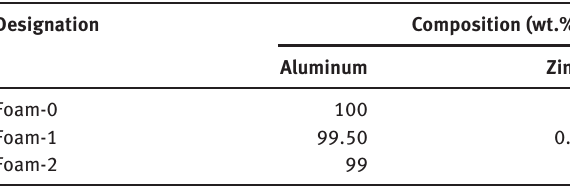
Table 1: Details of foam composition and